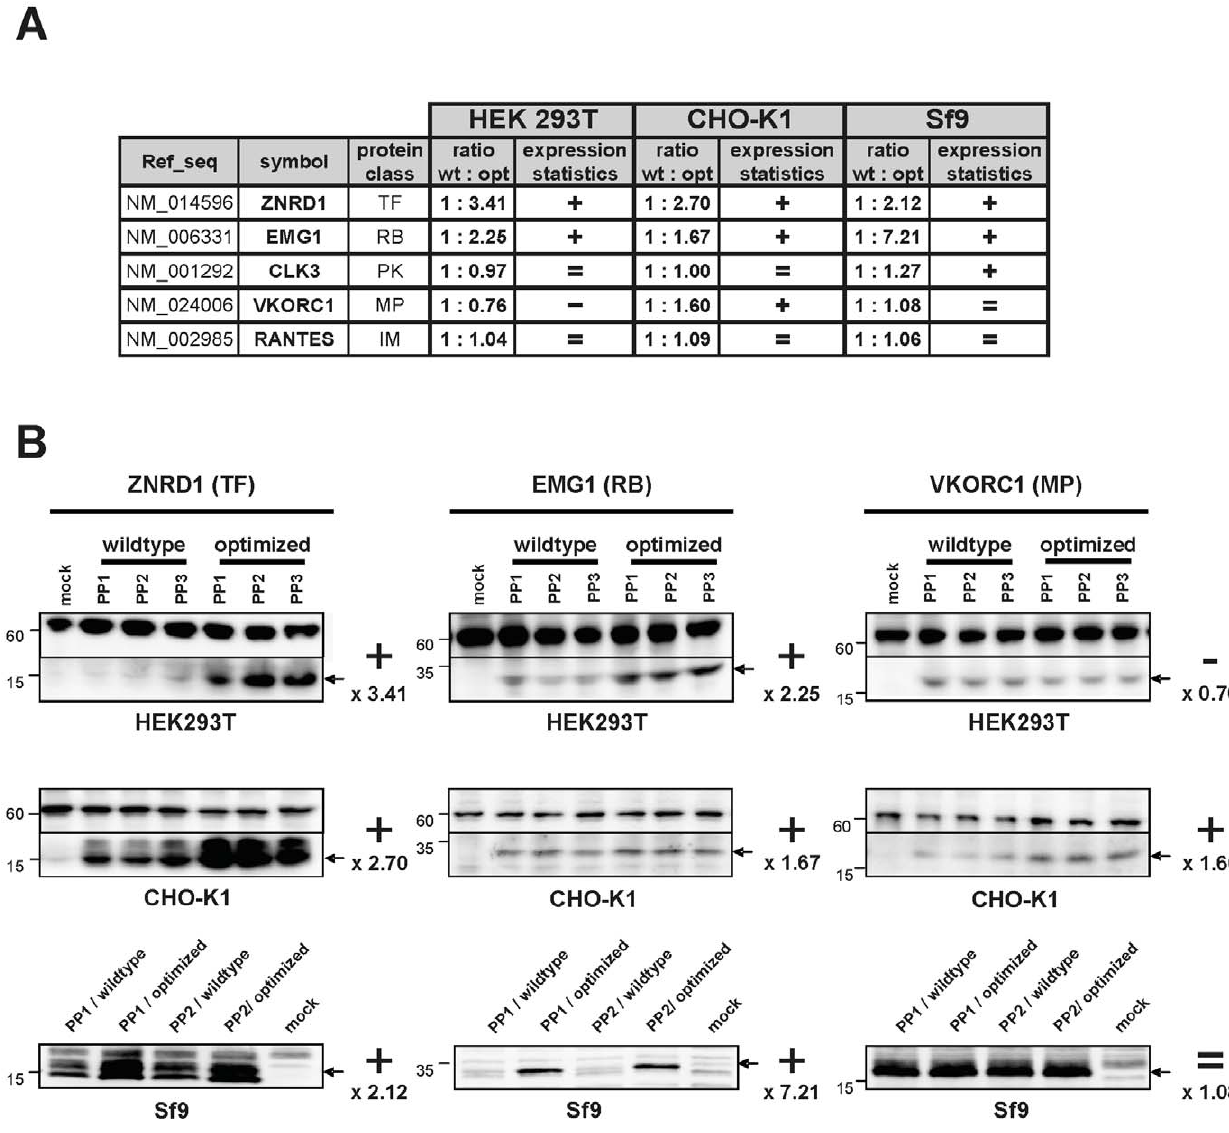
Figure 2. Comparative expression of human wildtype and human sequence-optimized gene constructs in HEK293T, CHO-K1 and insect-Sf9 cells. (A) Expression statistics for five representative proteins from each protein class. Mammalian HEK293T and CHO-K1 cells were transiently transfected in triplicate, whereas insect-Sf9 cells were transfected in duplicate. Relative protein expression of wildtype versus optimized genes (ratio wt:opt) was calculated from the mean expression values as described in Figure 1: ( + ) better expression of optimized gene; (=) comparable expression of both genes; ( 2 ) better expression of wildtype gene. (B) Western blot analyses of three representative proteins (panels left to right) transfected using three independent plasmid preparations (PP) into HEK293T and CHO-K1 cells, or two independent plasmid preparations into Sf9 cells (panels top to bottom). Signals from HEK293T and CHO-K1 cells were standardized against the , 60 kD cross-reactive band serving as loading control (visible also in the mock negative control lane). Left: molecular weight markers, right: the x-fold increase ( + ), decrease ( 2 ) or equivalence (=) in expression of the optimized genes.